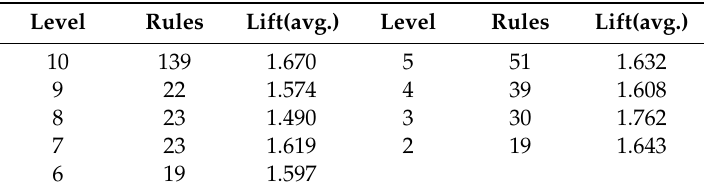
Table 8. Results of Experiment 1.